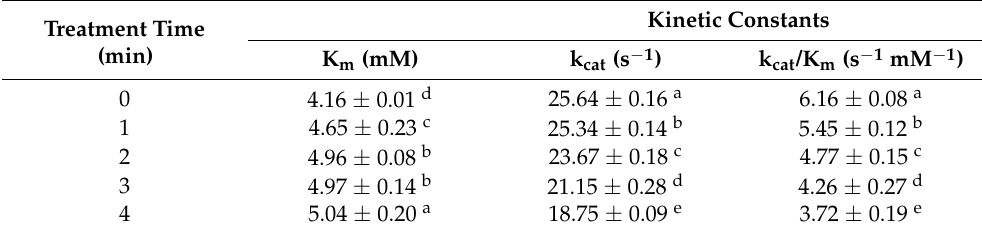
Table 2. Trypsin kinetic constants after ACP